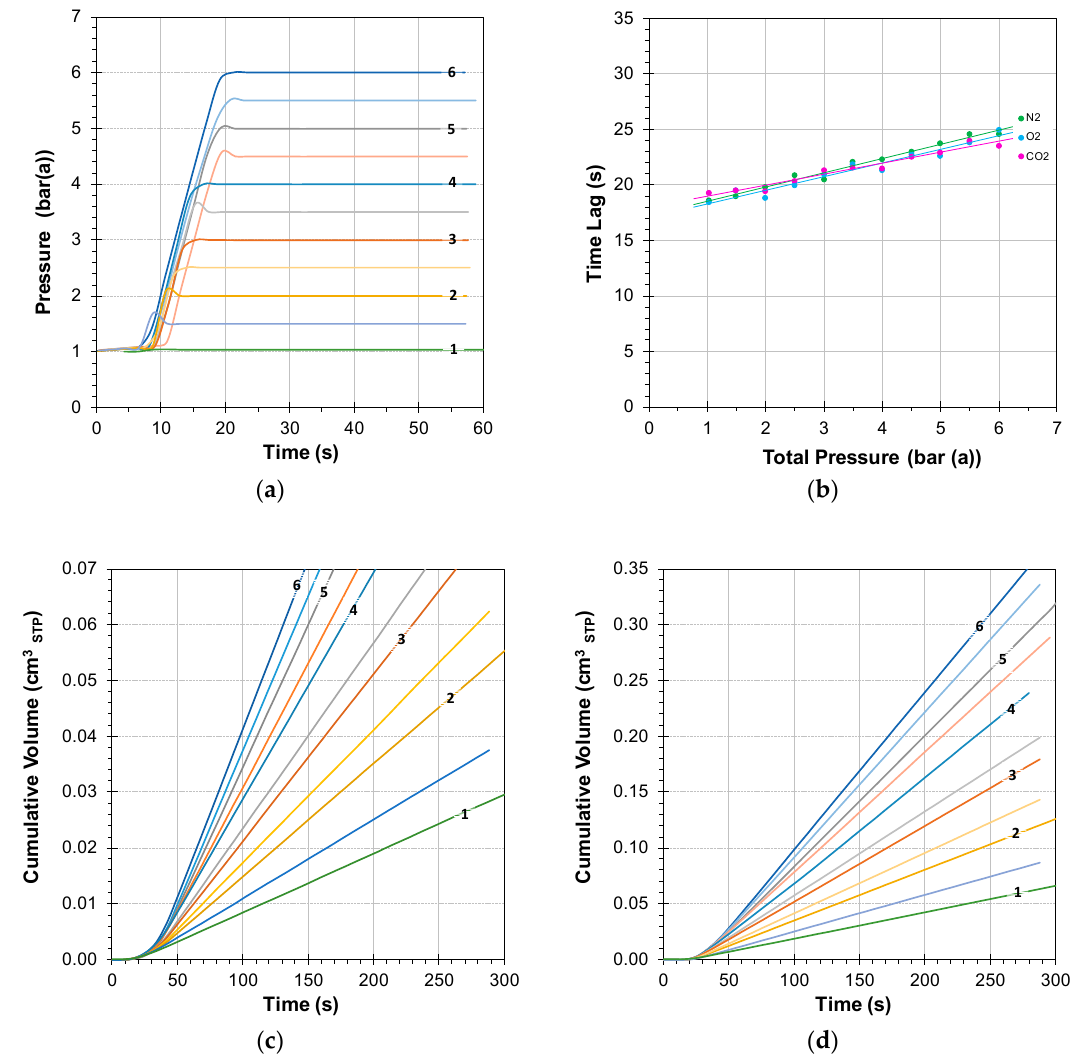
Figure 4. Plot of the increase of the feed pressure as a function of time upon switching of the six-way feed valve in Figure 3 from Argon purge gas to the 80/10/10 vol % N 2 /CO 2 /O 2 mixture, mimicking CO 2 -poor flue gas ( a ), and corresponding instrumental time lag ( b ) determined with an SBS TFC membrane (area 1.77 cm − 2 ). Examples of the individual time lag curves for N 2 ( c ) and CO 2 ( d ). Feed flow rate 500 cm 3 STP min − 1 and sweep flow rate 30 cm 3 STP min − 1 . The numbers on the curves in ( a , c ) and ( d ) indicate the feed pressure in bar(a); the intermediate curves are the half-integer values. At a lower feed flow rate of 200 cm 3 STP min − 1 , the filling-up time is ca. 25 s at 5 bar (SI Figure S2a),